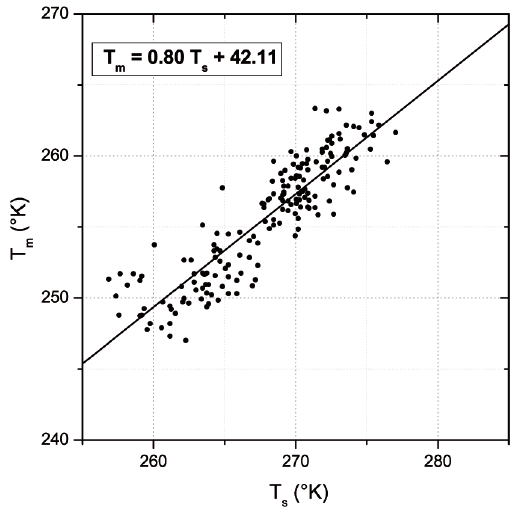
, s , computed from m